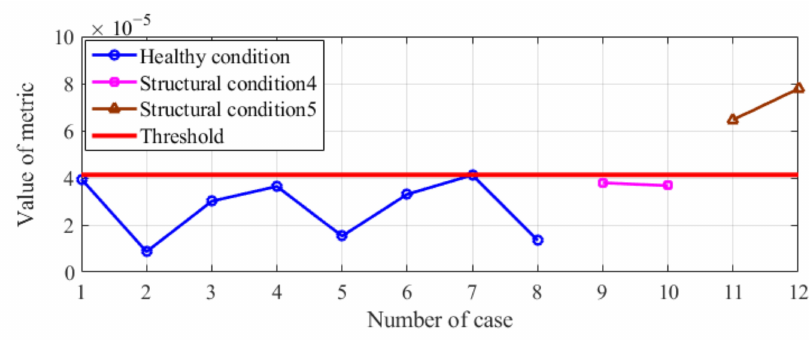
Figure 8. Results of condition diagnosis of the model bridge excited by di ff erent moving